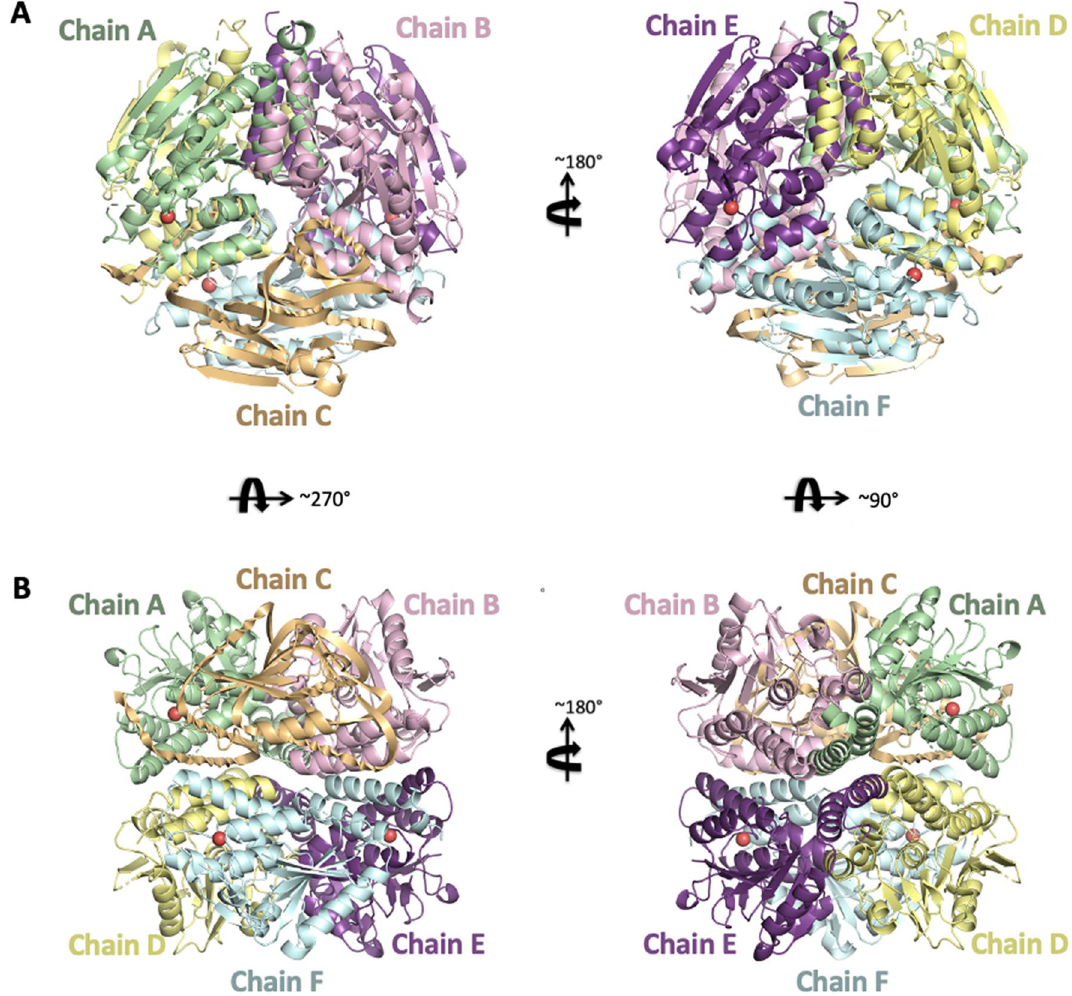
Figure 2. Cartoon representation of Nmar_1308 structure. ( A ) The overall structure of Nmar_1308 with the upper view is colored based on each chain. ( B ) The overall structure of Nmar_1308 with the side view is colored based on each chain. Chains are colored in pale green, light pink, light orange, pale yellow, violet purple and pale cyan, respectively. The critical water molecules which are present in chains A, E and F are indicated as red spheres. The figure is generated by PyMOL (www. schro dinger. com/